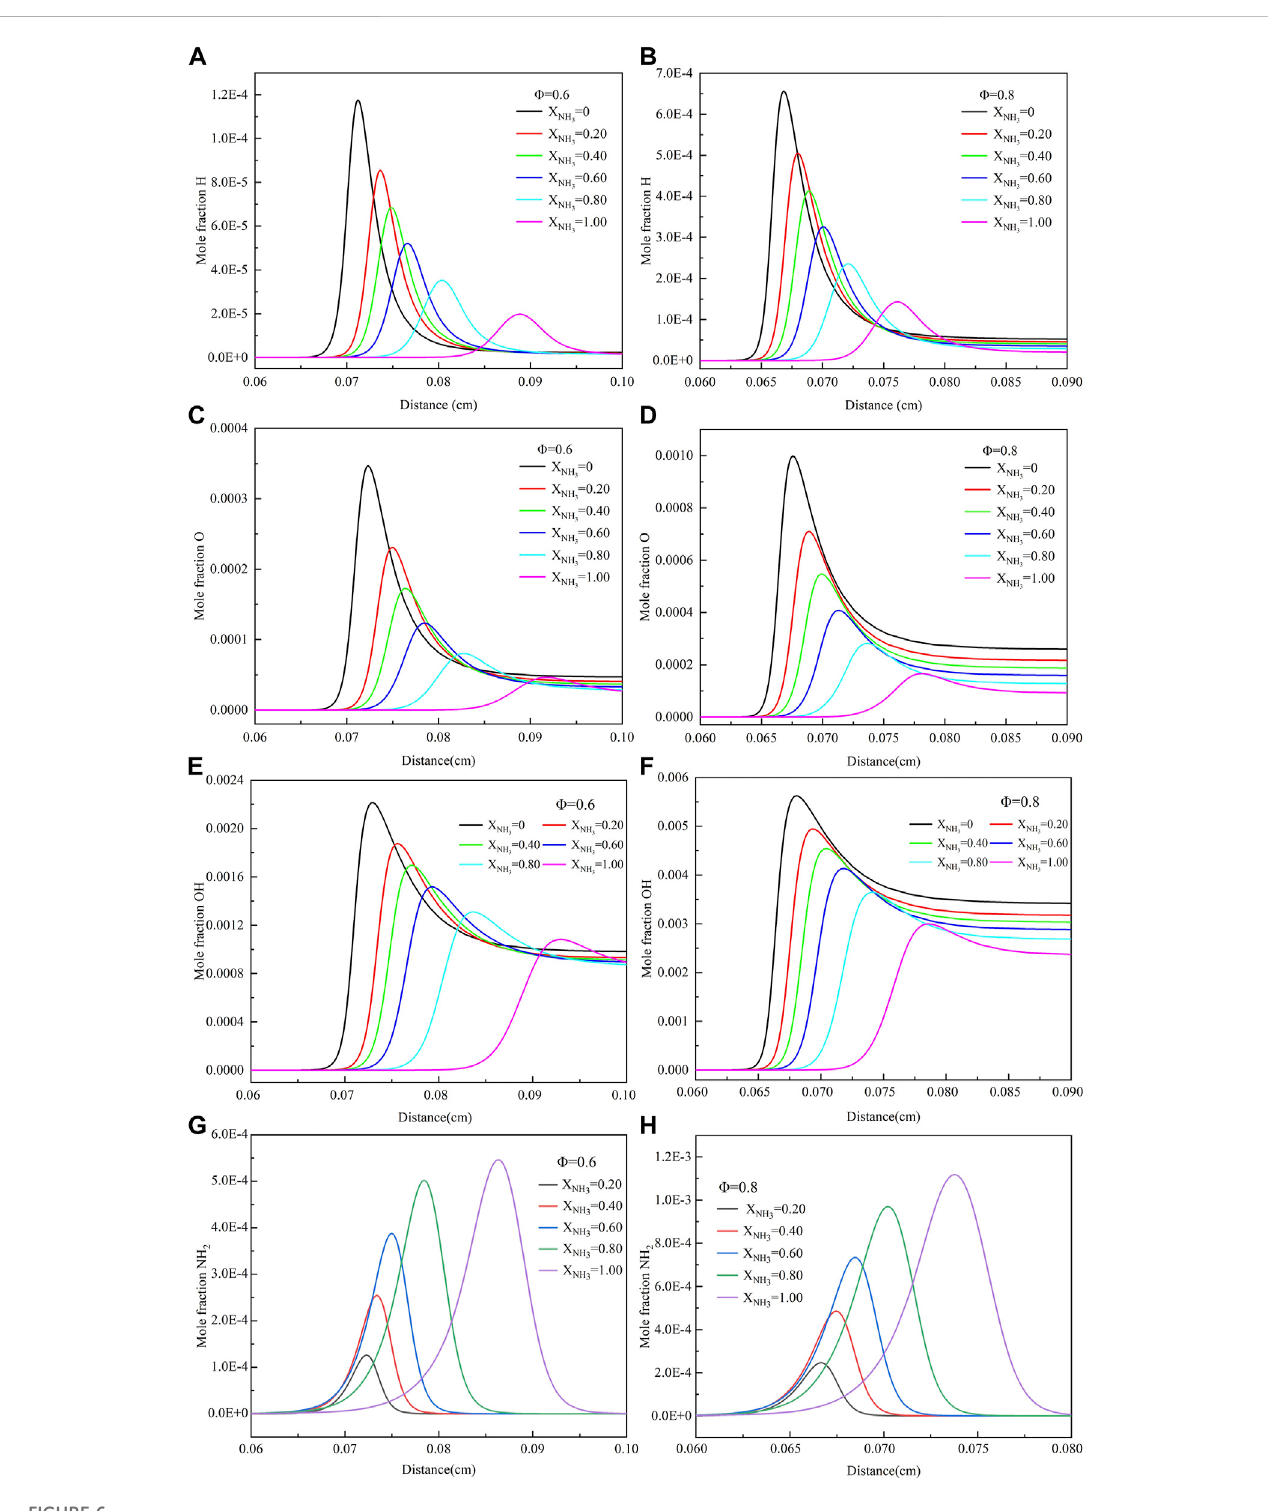
FIGURE 6 ThemolefractionofH,O,OH,andNH 2 withdifferentammoniacontent: (A) When Φ =.6,themolefractionofH; (B) When Φ =.8,themolefractionofH; (C) When Φ =.6,themolefractionofO; (D) When Φ =.8,themolefractionofO; (E) When Φ =.6,themolefractionofOH; (F) When Φ =.8,themolefractionof OH; (G) When Φ = .6, the mole fraction of NH 2 ; (H) When Φ = .8, the mole fraction of NH 2 . (T = 723 K, p = 16.5